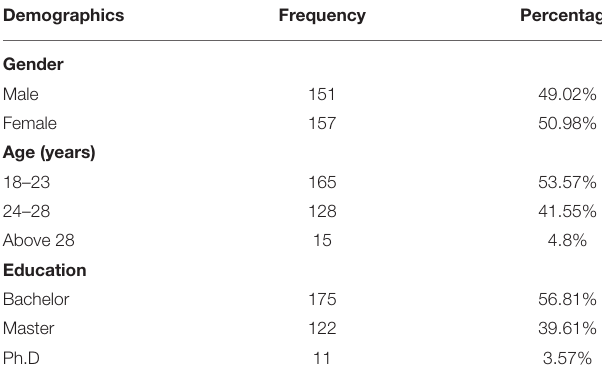
TABLE 1 | Demographics